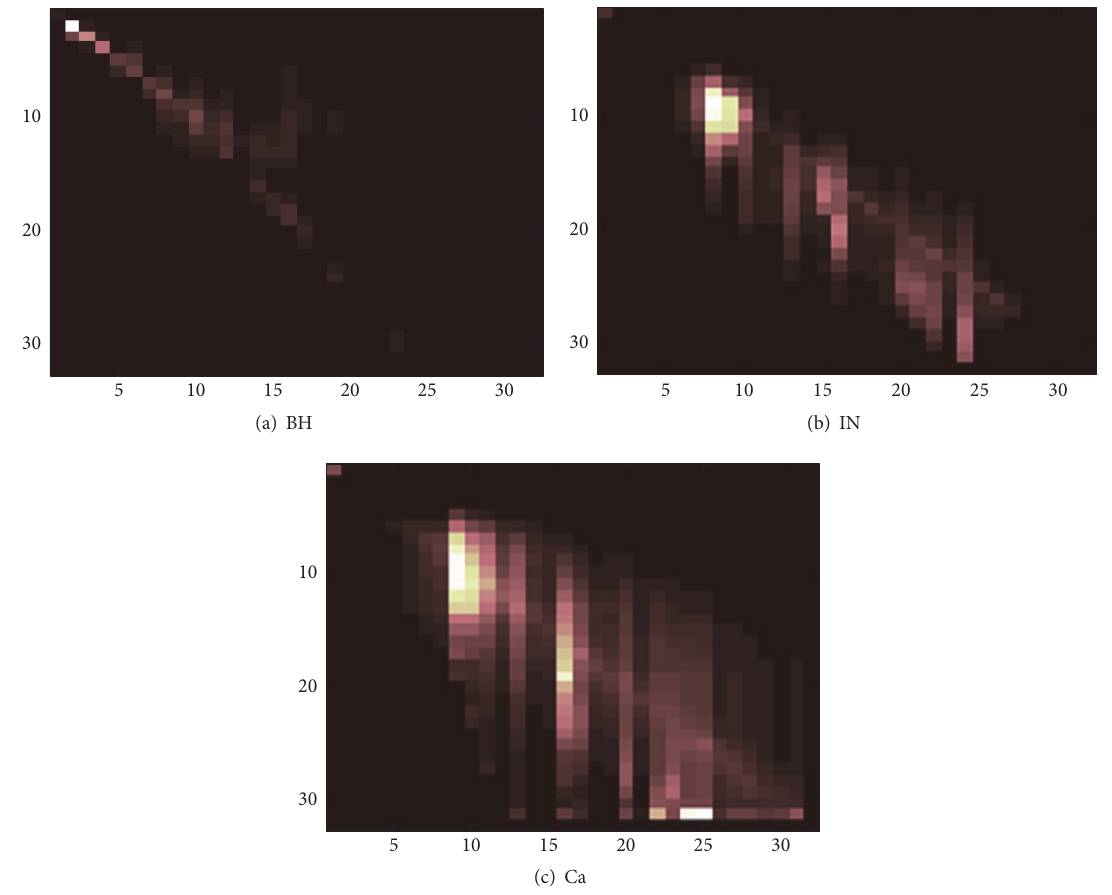
Figure 4: GLCM (32 gray levels) of multispectral bioimages is shown for all three ABC types. GLCM is in one direction ( 𝜃 = 0 ∘ , Ø = 0 ∘ ) and distance is constant ( 𝑑 = 1 , one pixel